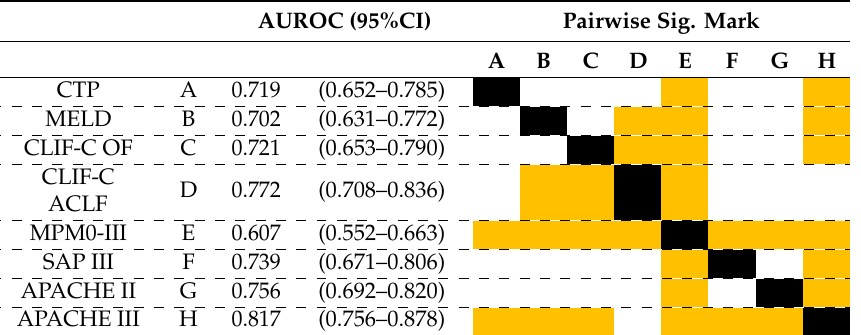
Table 2. Comparison of the 8 prognostic scores to predict overall mortality by AUROC. AUROC (95%CI) Pairwise Sig. Mark